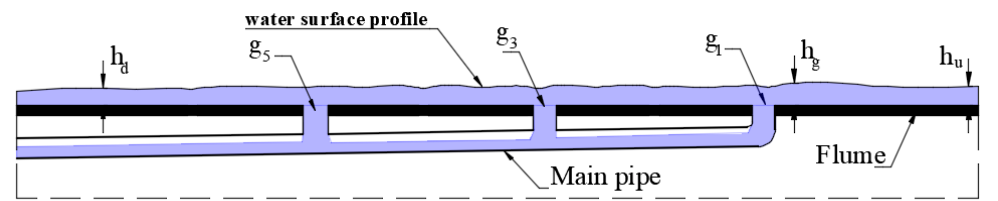
Figure 2. Plan of flume and arrangement of grates.